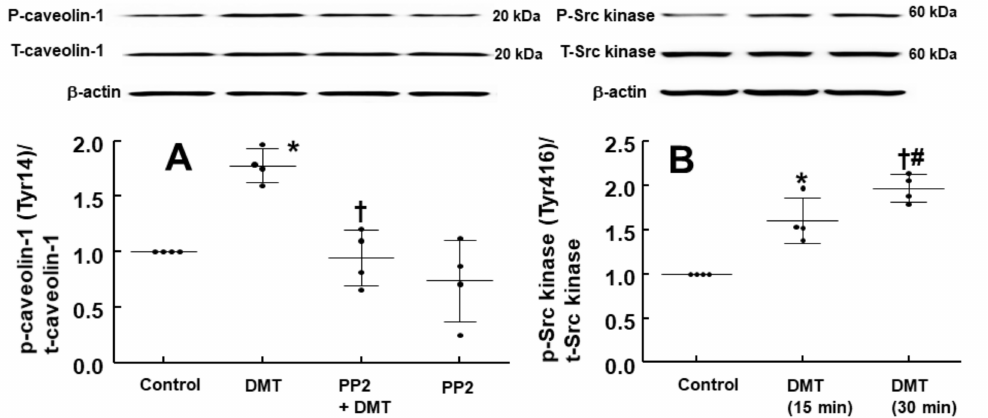
Figure 9. ( A ): Effect of PP2 on dexmedetomidine (DMT)-induced caveolin-1 (Tyr14) phosphorylation in human umbilical vein endothelial cells (HUVECs). HUVECs were treated with DMT (10 − 6 M) alone for 90 min and with PP2 (5 × 10 − 6 M) for 1 h, followed by treatment with DMT (10 − 6 M) for 90 min or PP2 (5 × 10 − 6 M) alone for 150 min. Data ( n = 3) are shown as mean ± standard deviation. n indicates the number of independent experiments. * p < 0.01 versus control. † p < 0.001 DMT alone. P-caveolin-1, phosphorylated cavelin-1; T-caveolin-1, total caveolin-1. ( B ): Effect of DMT on Src kinase (Tyr416) phosphorylation in HUVECs. HUVECs were treated with DMT (10 − 6 M) alone for 15 min and 30 min. Data ( n = 4) are shown as mean ± standard deviation. n indicates the number of independent experiments. * p < 0.01 and † p < 0.001 versus control. # p < 0.05 versus DMT (15 min). P-Src kinase, phosphorylated Src kinase; T-Src kinase, total Src